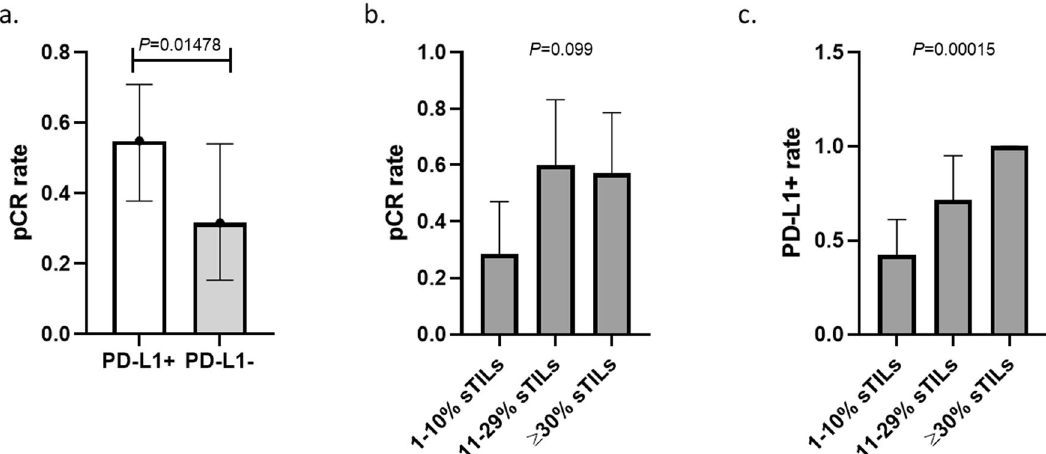
Fig. 2 Distribution of pCR rate by PD-L1 status and manual stromal TILs (sTILs). a pCR rates in the PD-L1-positive (55%; 95% CI: 0.38 – 0.71) and -negative (32%; 95% CI: 0.15 – 0.54) groups, p = 0.148 (two-sided Fisher ’ s exact test). b pCR rates in cancers with ≥ 30% sTIL (pCR 57%), 29 – 10% sTIL (pCR 60%), and <10% sTIL (pCR 29%) groups, p = 0.099 (two-sided Fisher ’ s exact test). c PD-L1 positivity rates in cancers with sTIL >30%, sTIL 29% – 10%, and sTIL <10%, were 100%, 71% and 42%, respectively, p = 0.00015 (two-sided Fisher ’ s exact test). On all panels error bars represent standard deviations